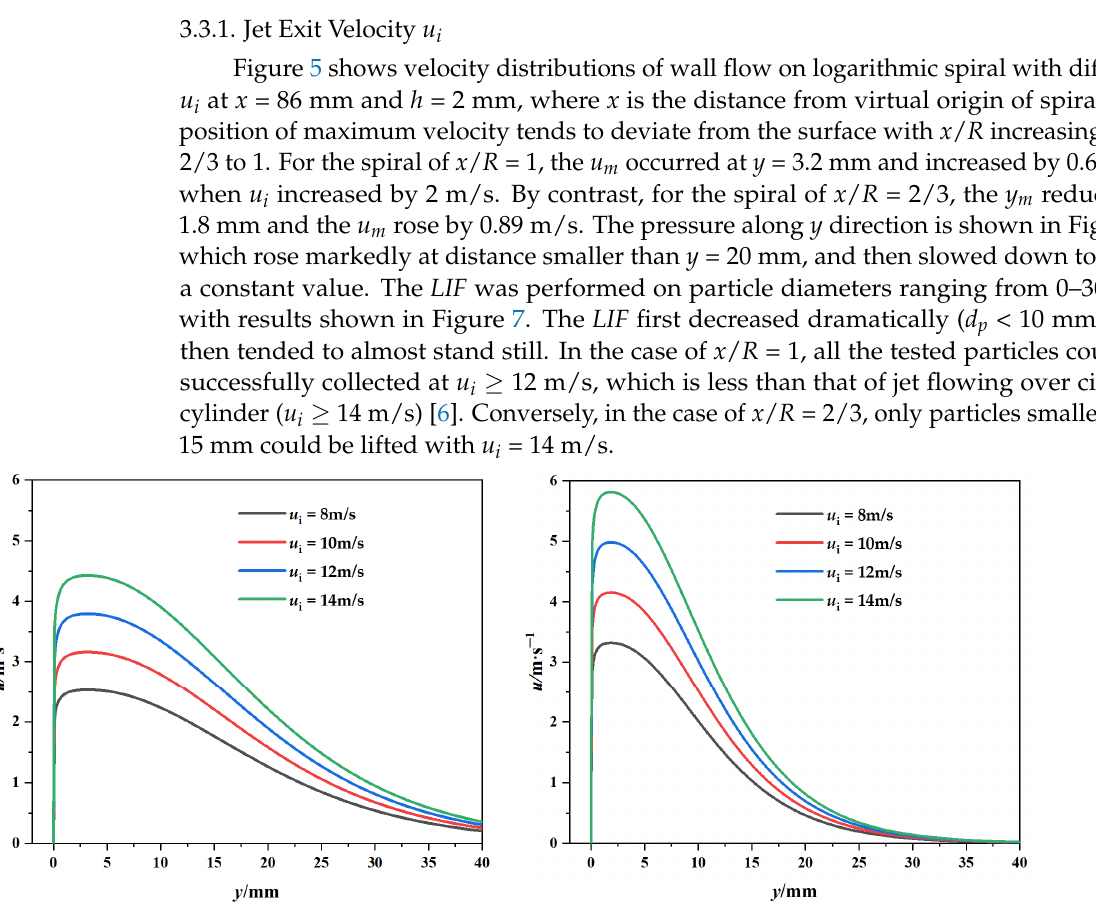
( b ) Figure 6. Pressure distribution with different u i over logarithmic spiral wall surfaces at ( a ) x / R = 1 and ( b ) x / R = 2/3.